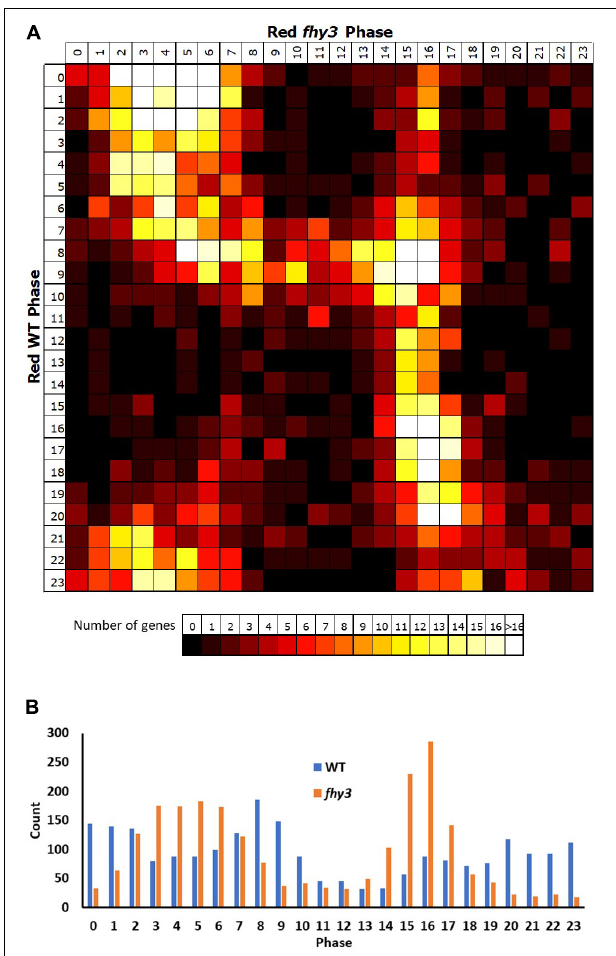
FIGURE 6 | Rhythmic genes show a concentration in morning and early night phases in fhy3 in red light. Phases of genes identified as rhythmic in both wild type and fhy3 in red light based on microarray data. (A) Genes were grouped by their calculated phases in each genotype and numbers of genes for each phase combination were represented as a heatmap. (B) Total number of genes displaying each phase in the two genotypes.